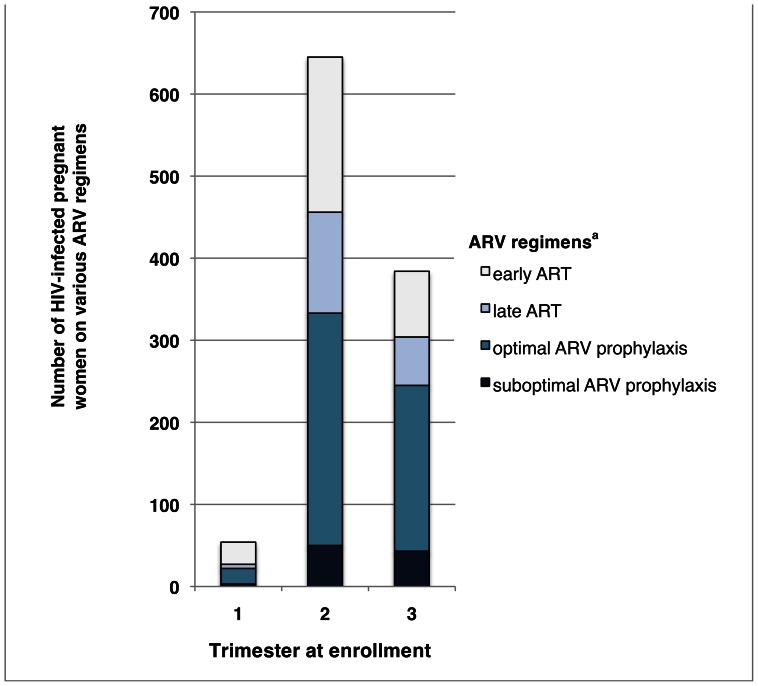
Antiretroviral regimen by trimester at enrollment.
aFor explanations of ARV regimen categories please refer to Figure 1. Abbreviations: ART (antiretroviral therapy), ARV (antiretroviral).